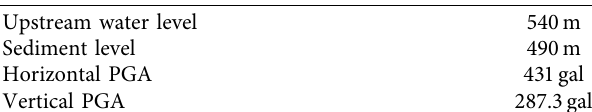
Figure 12: Vertical contraction joints. Table 2: Load